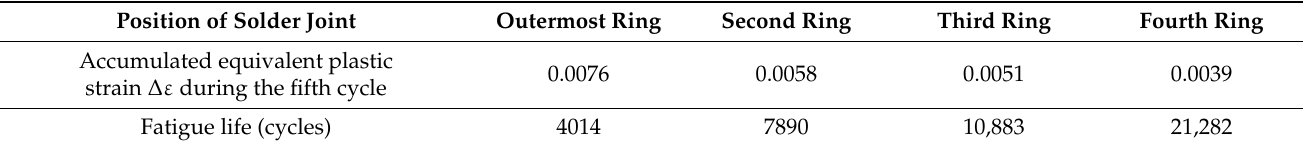
Table 5. Fatigue life of solder joint on outer four rings.